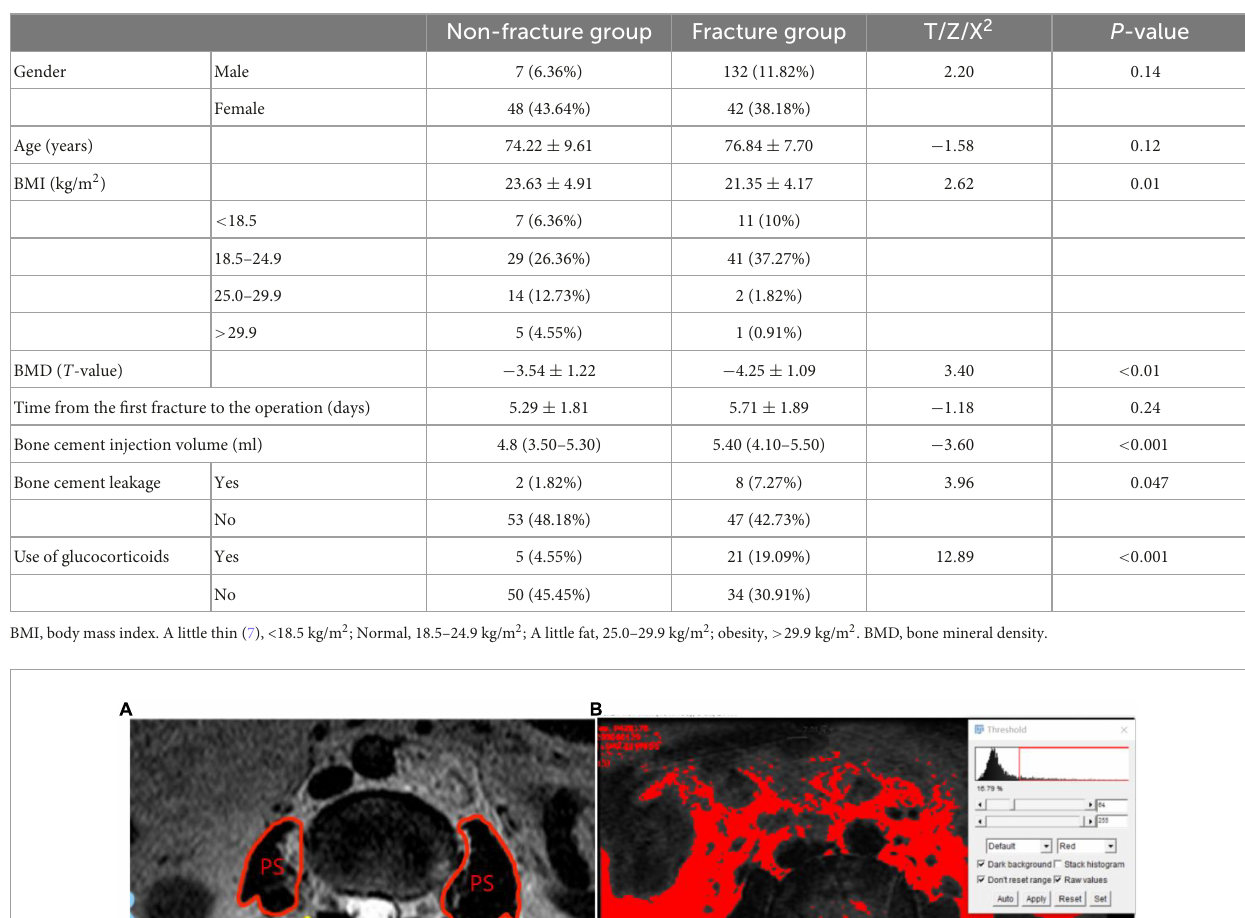
by 100%; fat infiltration rate asymmetry (FIRA) of paraspinal muscles: (the FIR of paraspinal muscles on the larger side minus the FIR of paraspinal muscles on the smaller side)/the FIR of paraspinal muscles on the larger side, then multiplied by